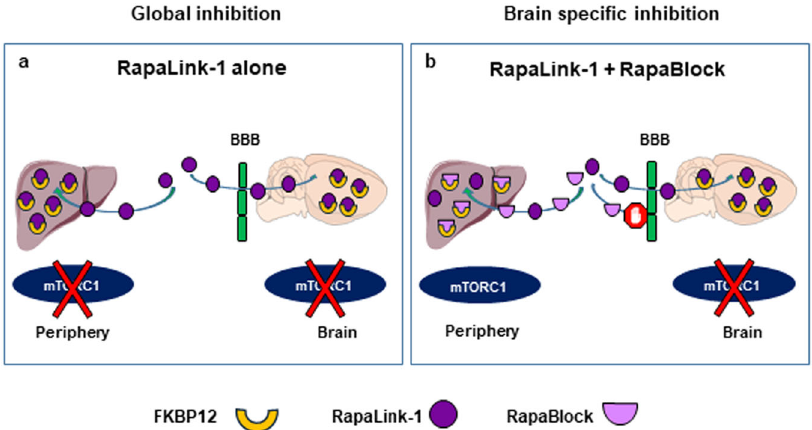
Fig. 1 Schematic representation of strategy. a Systemic administration of RapaLink-1 (purple) inhibits mTORC1 in the periphery and in the brain. b RapaBlock (pink), a small molecule that does not cross the blood – brain barrier (BBB) (green) and competes with RapaLink-1 (purple) for FKBP12 (yellow) binding in the periphery, protects mTORC1 activity outside of the CNS. Systemic co-administration of RapaLink-1 and RapaBlock allows for brain-speci fi c inhibition of